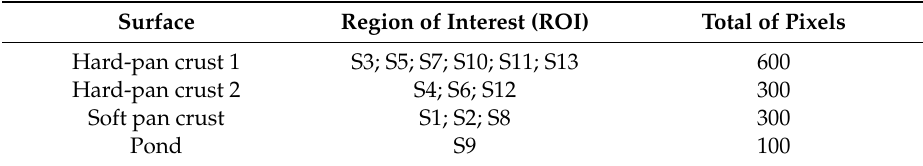
Table 2. Regions of interest (ROIs) surface distribution and basic